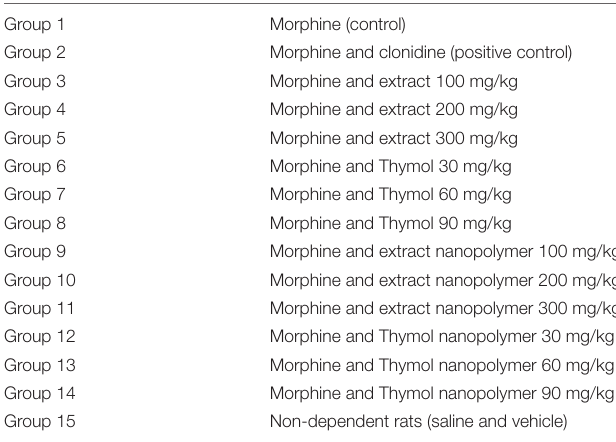
TABLE 1 | Animals grouping and Thymbra spicata extract, thymol, extract nanopolymer, and thymol nanopolymer used to create dependence and morphine withdrawal